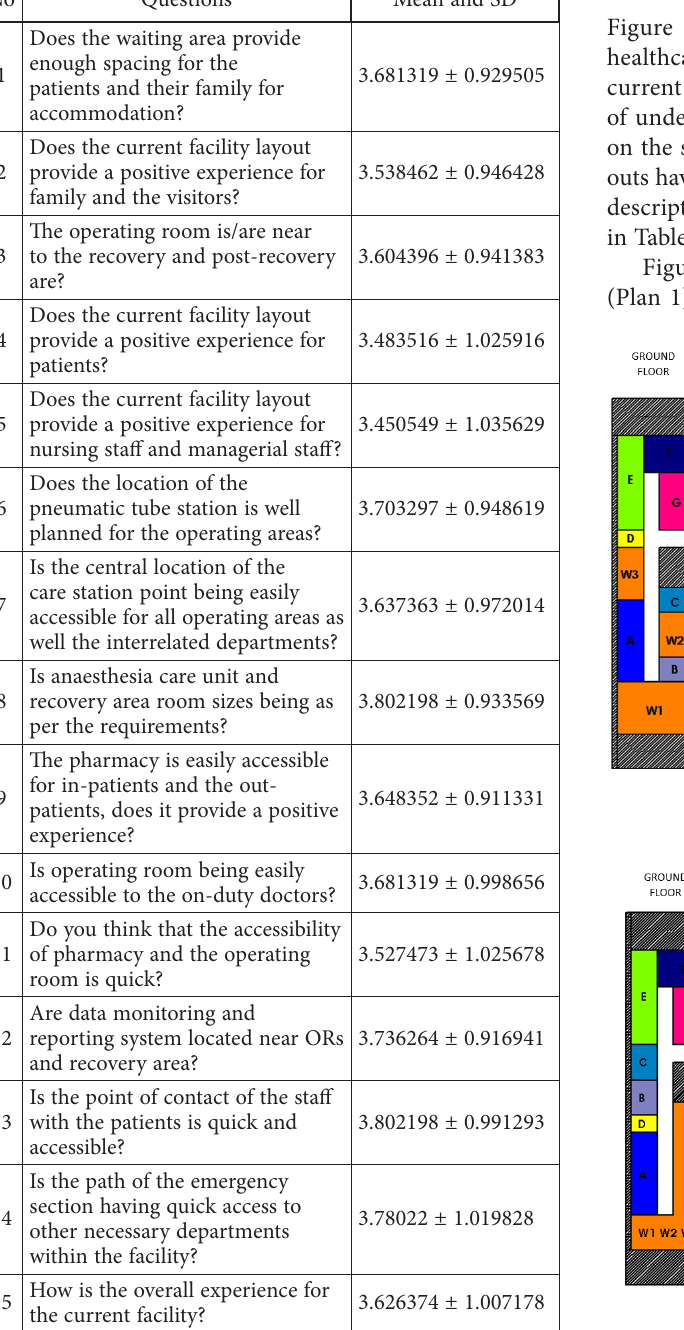
Table 1. Survey questionnaire along with statistical analysis